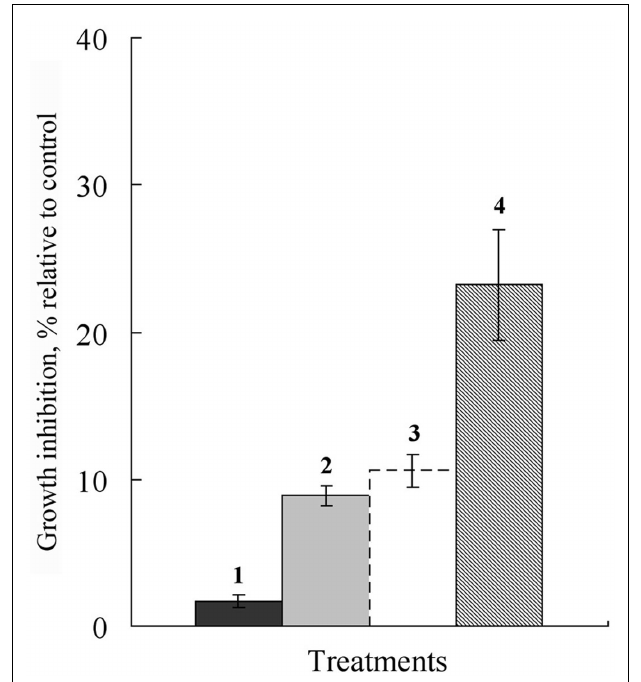
FIGURE 6 | Histograms showing percent growth inhibition of A. alternata affected by 2,3-DHBA and Folicur added in Czapek agar individually or in combinations with each other at 7days after application. ( 1) 2,3-DHBA, 1.0ppm; ( 2) Folicur, 0.5ppm; ( 3) predicted growth inhibition based on sum of 1 and 2 ; ( 4) Folicur, 0.5ppm and 2,3-DHBA, 1.0ppm. Bars represent double SE.